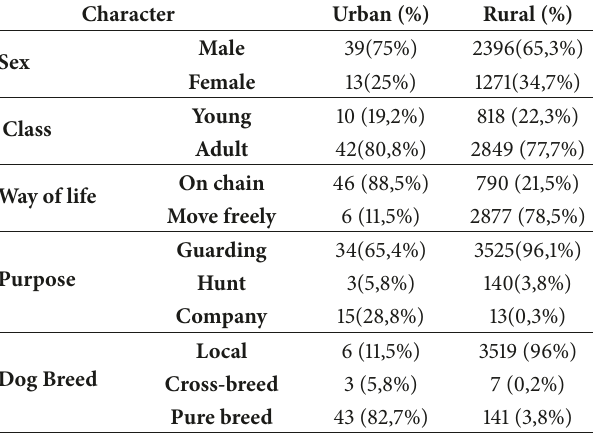
Table 3: Ecological characteristics of dogs